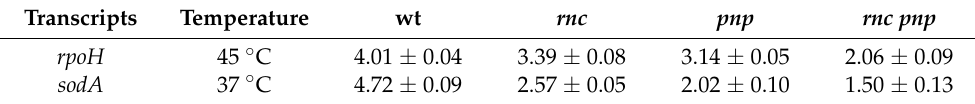
Table 1. Effect of rnc and pnp mutations on the decay rates of rpoH and sodA mRNAs.